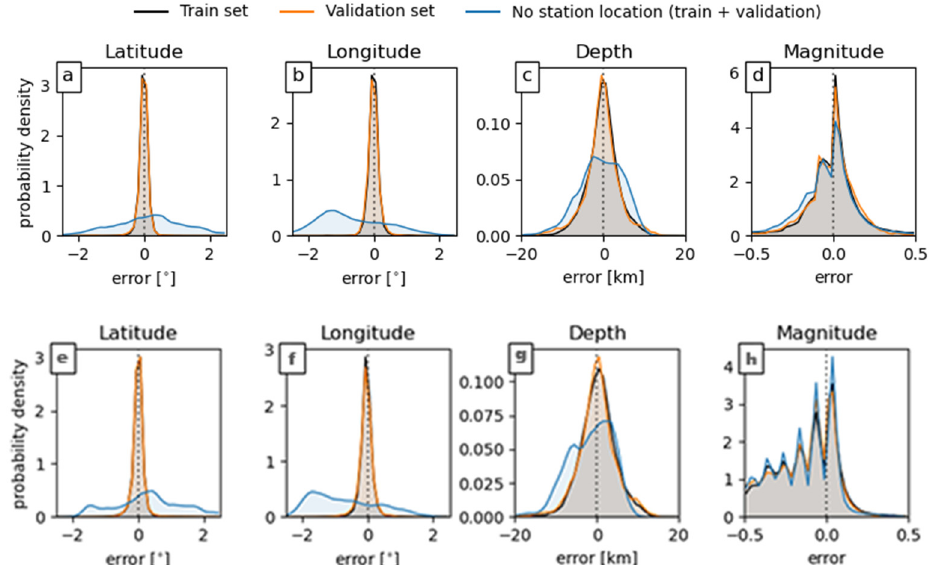
Figure 8. Prediction errors of the GNN from ( a – d ) and BNGCNN from ( e – h ) models to predict latitude, longitude, depth, and magnitude of a seismic event without and with using station location information. With station spatial information, the black line shows the training error on the training subset while the yellow line shows the validation error on the validation set. The blue line shows the prediction error on combined training and validation subsets without location information.